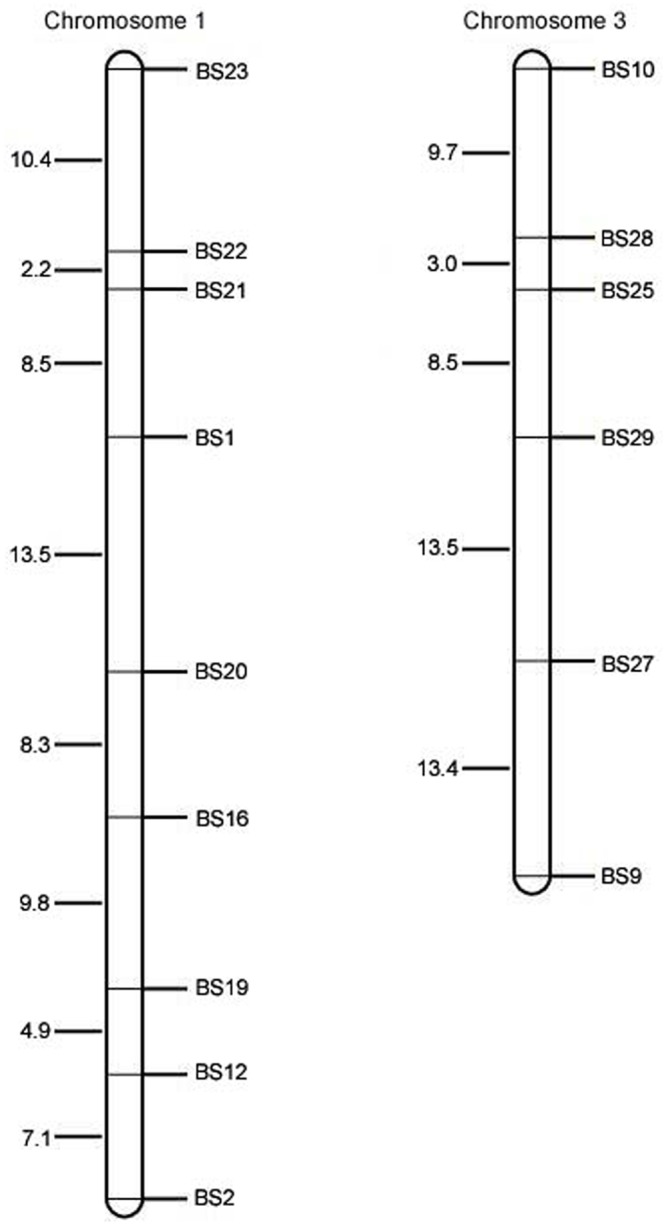
The genetic map of the F2 population derived from the cross of sorghum Tx623A and sudangrass Sa.